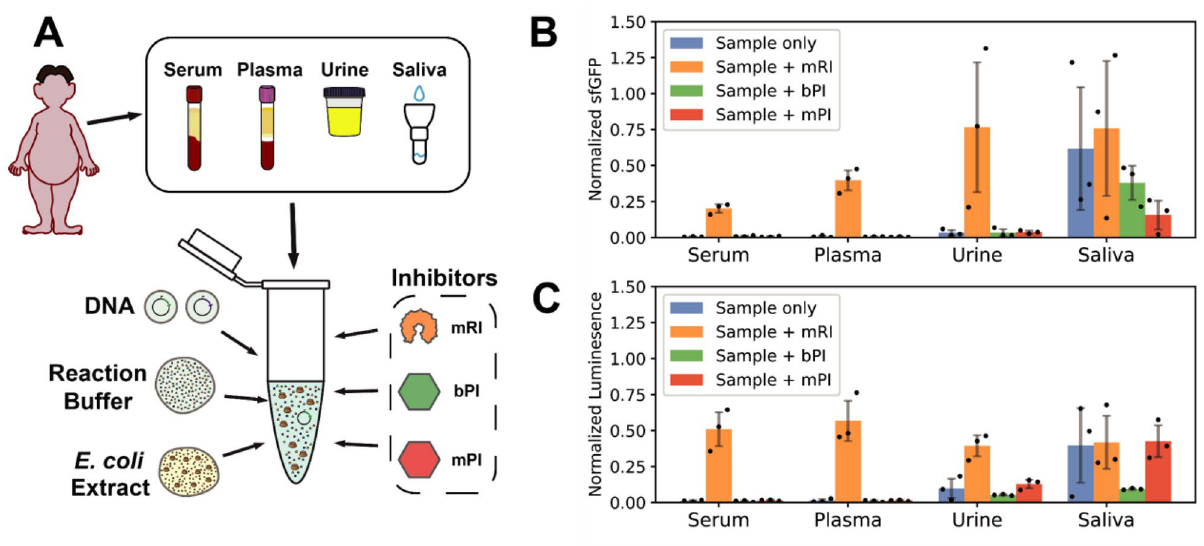
Figure 1. Deleterious clinical sample matrix effect on reporter expression is partially recovered by commercial RNase inhibitor. ( A ) Plasmids encoding sfGFP and luciferase proteins were mixed with E. coli cell extracts, optimized reaction buffer, and clinical samples (serum, plasma, urine, or saliva). ( B , C ) Quantification of the matrix effects. 100 nM of constitutively expressing sfGFP ( B ) or luciferase ( C ) plasmids was added to a cell- free system containing 10% clinical sample with or without murine RNase inhibitor (mRI), bacterial protease inhibitor (bPI), or mammalian protease inhibitor (mPI). All measurements were normalized relative to the positive control (without clinical sample or inhibitors). Each clinical sample is a pool from three different individuals. Data are the mean of three experiments performed on three different days. Error bars correspond to ±